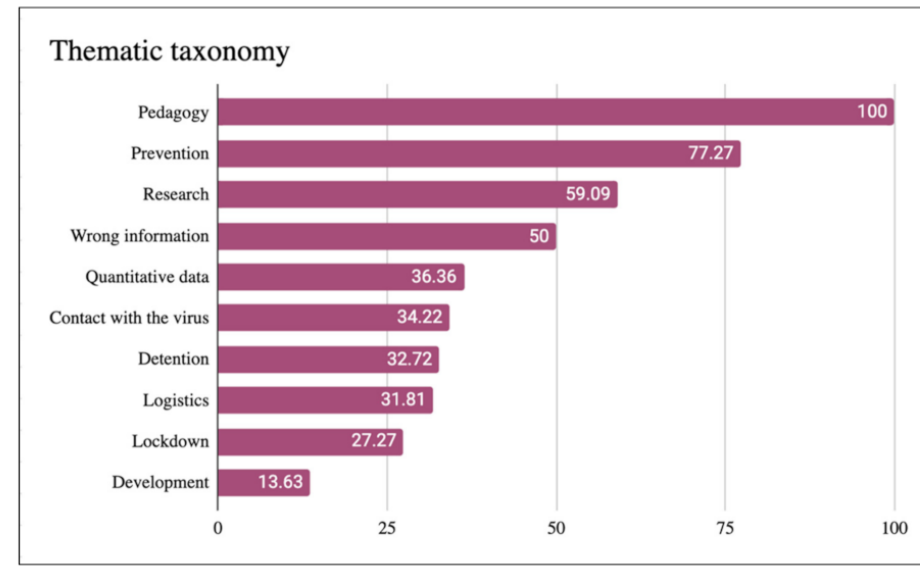
Figure 1. Thematic taxonomy in